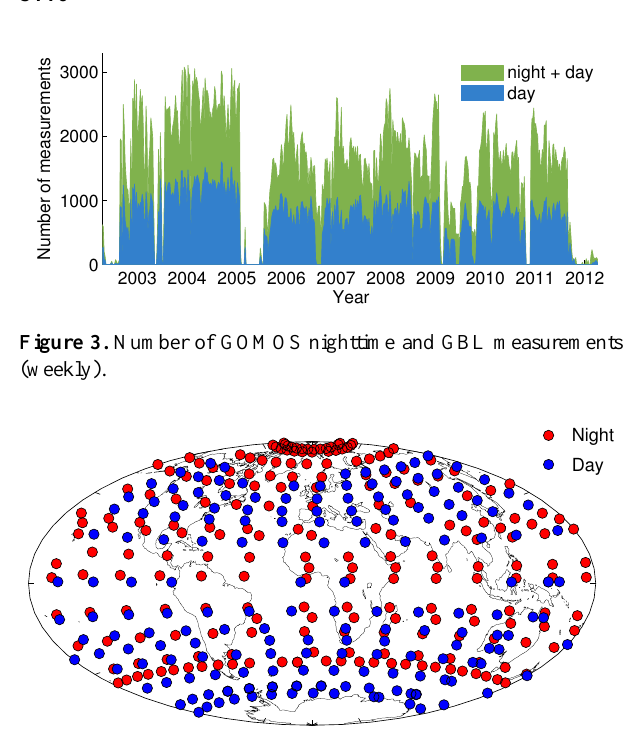
Figure 4. Typical 1-day coverage of GOMOS night occultations (red) and GBL (blue). Data from 15 December 2004.